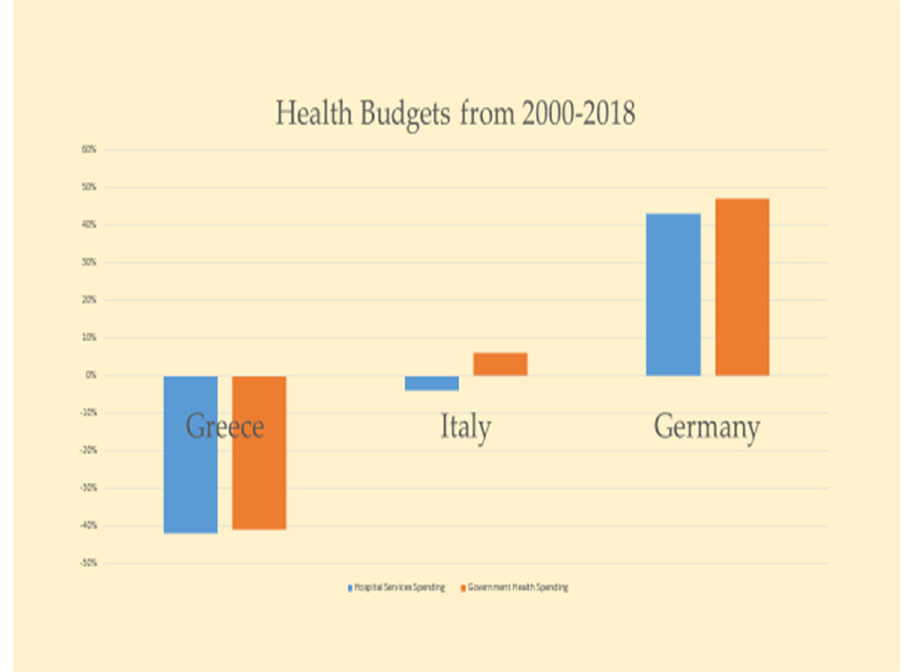
Figure 14. Percentage of Public Health Spending (2000–2018).